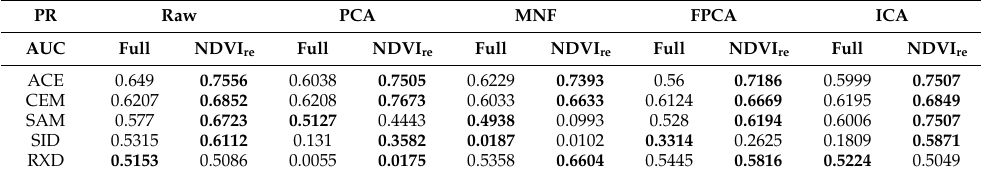
Table 4. Comparison between the AUC of the PR curves using the full and spatial DR images.